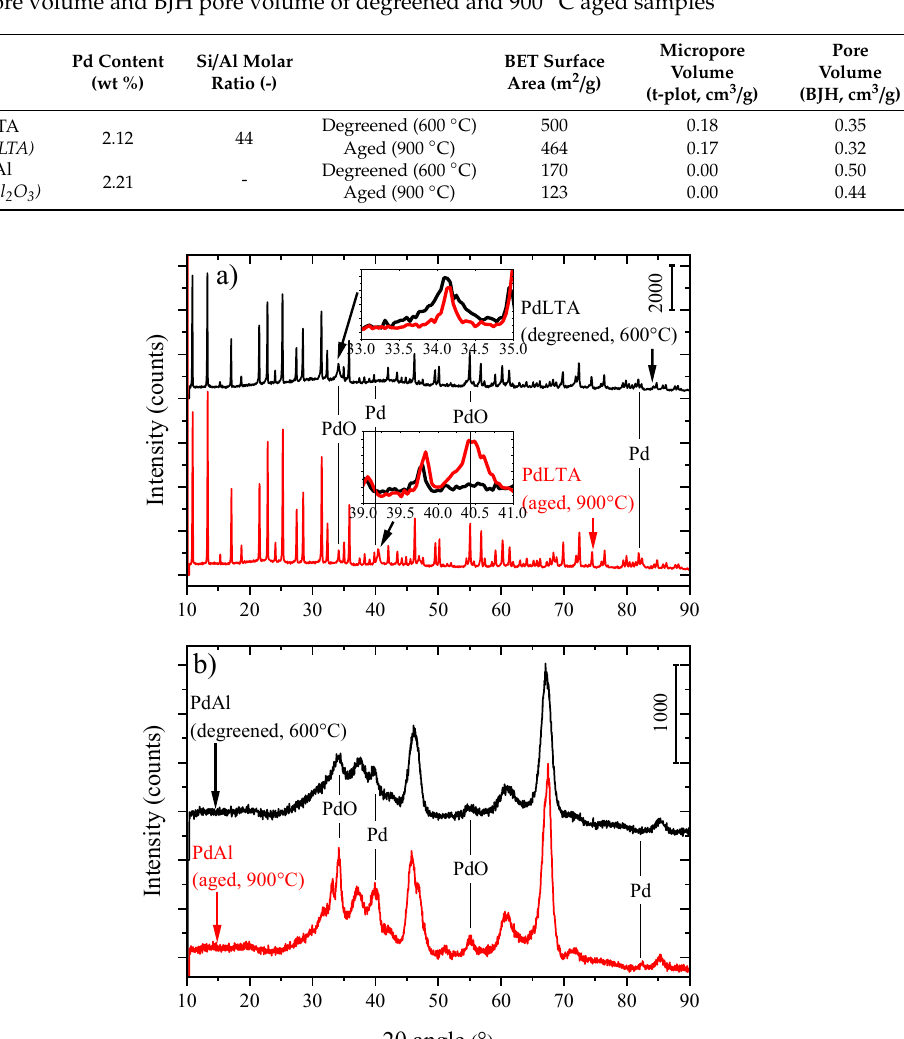
Figure 1. X-ray diffraction (XRD) patters of ( a ) PdLTA and ( b ) PdAl. Black lines represent degreened sample and red lines show the samples after hydrothermal aging at 900 °C.